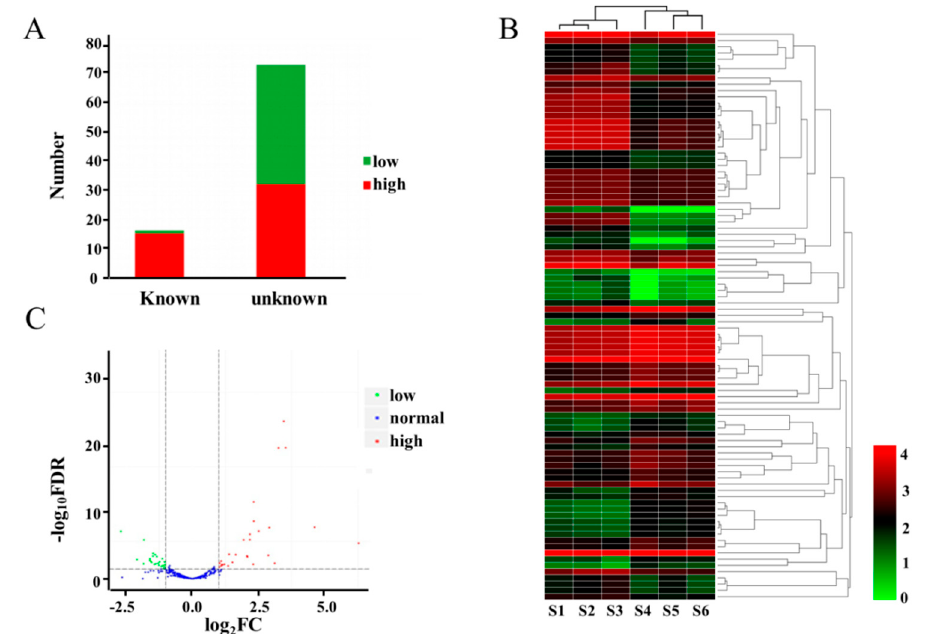
Figure 3. Expression profiles of the di ff erentially expressed miRNAs (DEMs) between dmc and WT. ( A ) Stacking bar diagram of the DEMs; ( B ) Heatmap of the DEMs. S1, S2, S3: mutant dmc ; S4, S5, S6: WT. The color scale indicates the values of LgFPKM; FPKM: fragments per kilobase of transcript per million. ( C ) Volcano plots of the DEMs. The red dots represent the highly expressed DEMs in dmc , green dots represent the lowly expressed DEMs in dmc, and blue dots represent no di ff erence in DEM expression between dmc and WT; FC: fold change; FDR; false discovery rate.